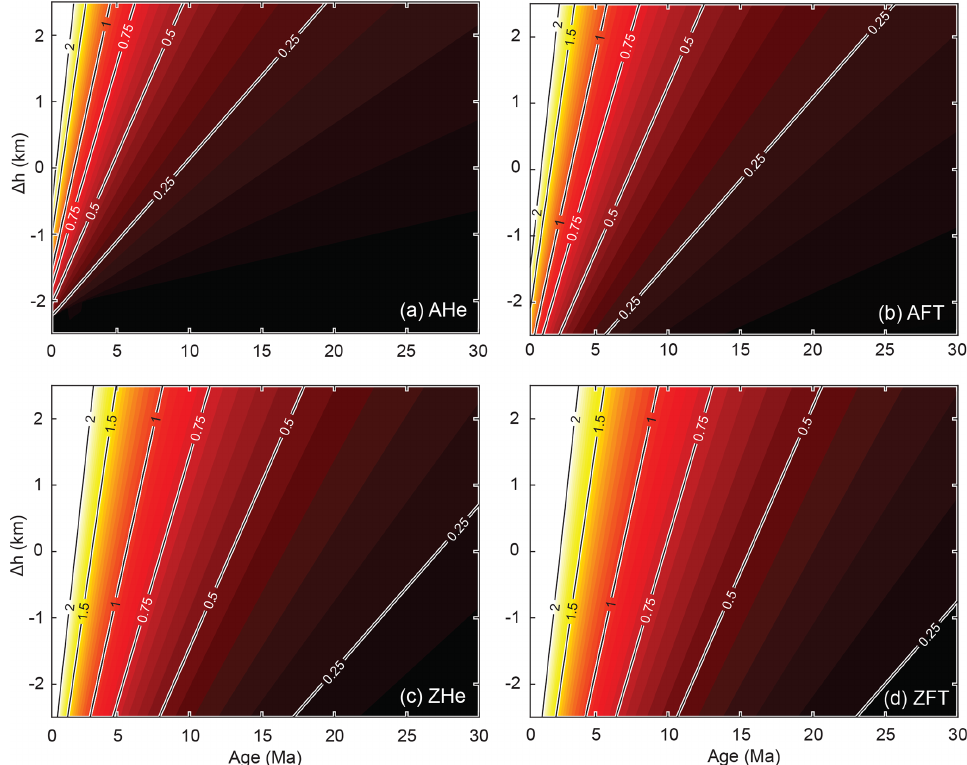
Figure 2. Contour plots of exhumation rate for different age– (cid:49)h combinations. These can be thought of as age–elevation relationships for different constant exhumation rates. Plots are shown for the (a) AHe, (b) AFT, (c) ZHe, and (d) ZFT systems; exhumation-rate contours are shown every 0.05kmMyr − 1 from 0 to 2.0kmMyr − 1